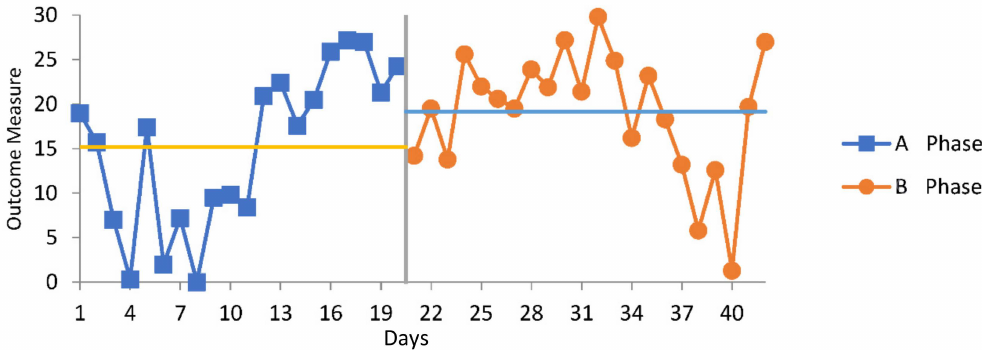
Figure 4. Psychological Wellbeing changes from phase A to B for P2.